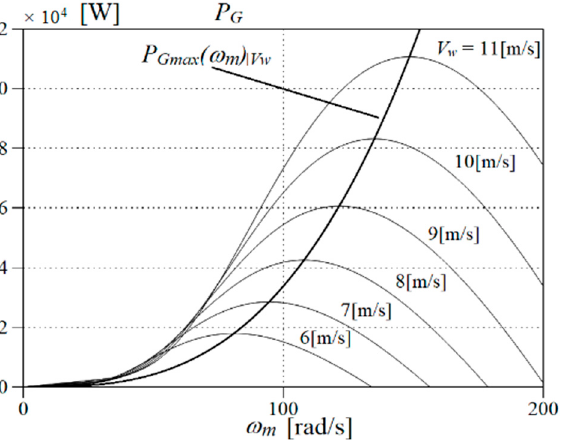
Figure 2. Generator power P G in relation to the angular speed ω m for different wind speeds V w and β = 0°